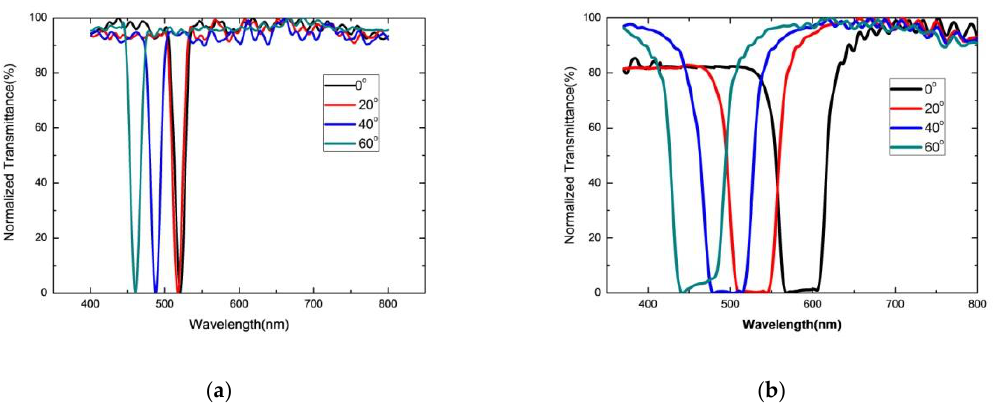
Figure 7. Central wavelength variation of ( a ) templated blue phase liquid crystals and ( b ) templated cholesteric liquid crystals in green color.